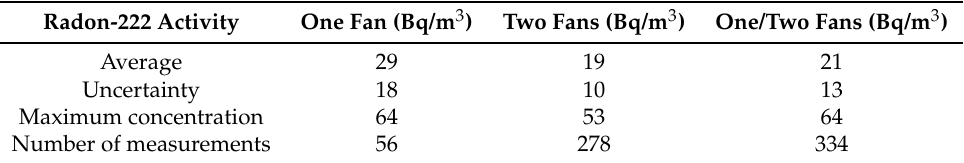
Table 3. Concentration after installation of fans.